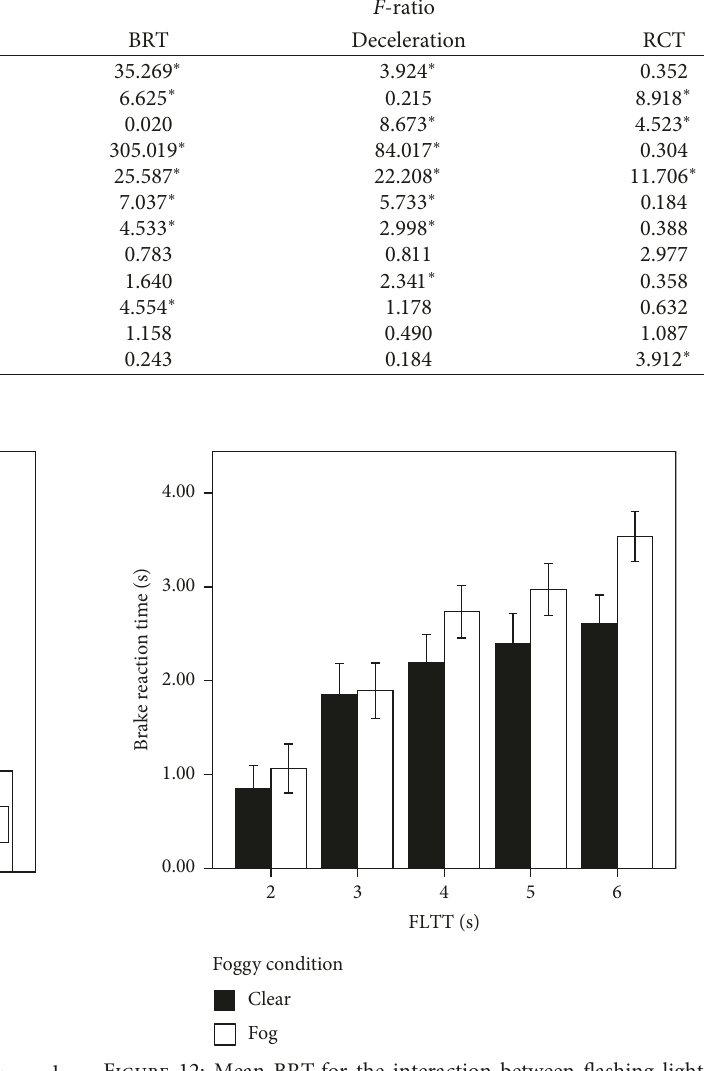
Figure 11: Mean BRTfor the interaction between crossing type and gender.